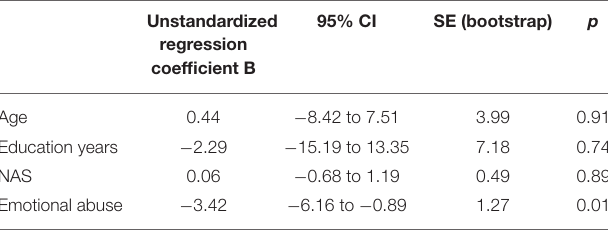
TABLE 1 | Bootstrapping regression of emotional abuse on the 1 RT for disgust